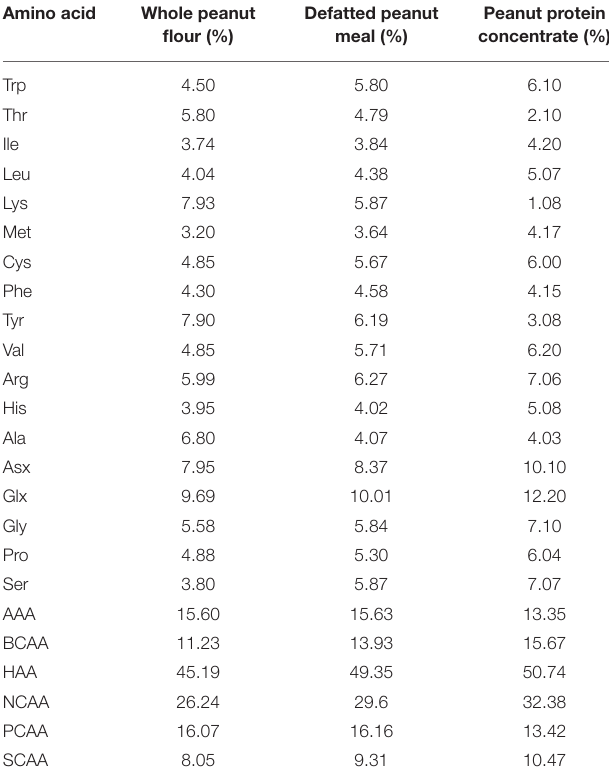
TABLE 2 | Amino acid profile of whole peanut flour, defatted peanut protein meal, and peanut protein concentrate*. Amino